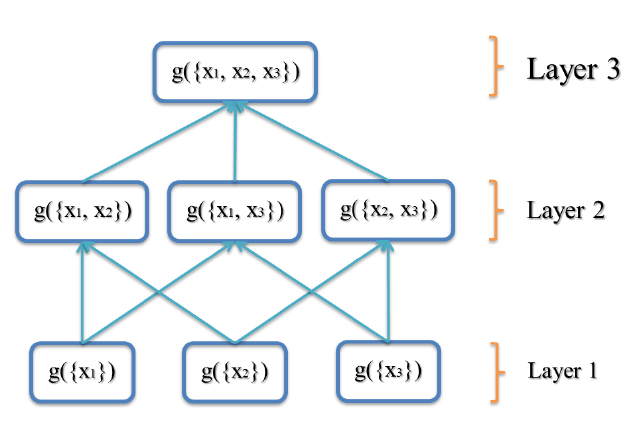
Figure 1. Fuzzy measure shown for three information